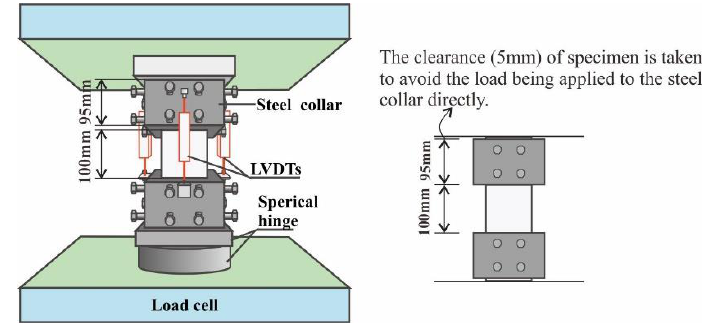
Table 4. Fiber addition in LWAC mixtures.